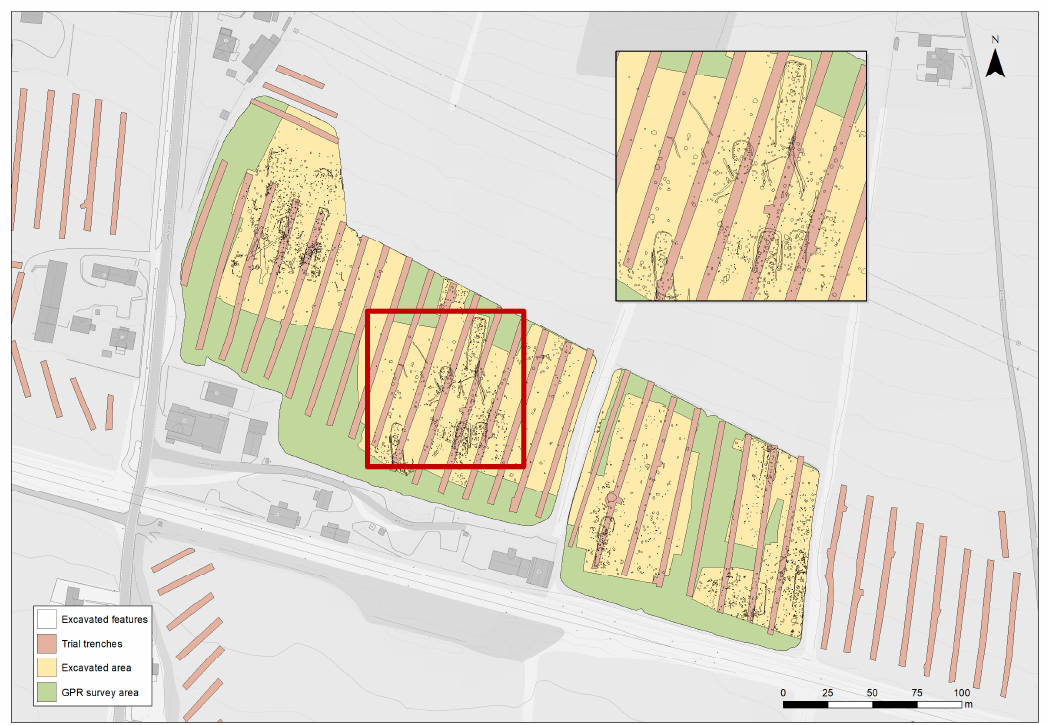
Figure 7. Map showing the extent of trial trenches, GPR survey areas, and topsoil stripping at Dilling. Map source: The Museum of Cultural History, Østfold county council, The Norwegian Mapping Authority, Geovekst and Municipalities,